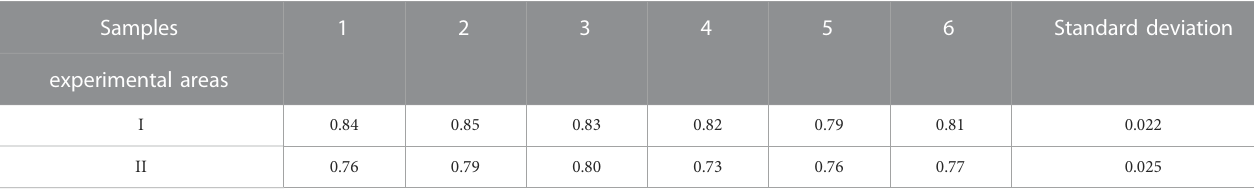
TABLE 9 Standard deviation based on RCC5/RCC8/RCC11 of each data in experimental area I and II. Samples experimental areas